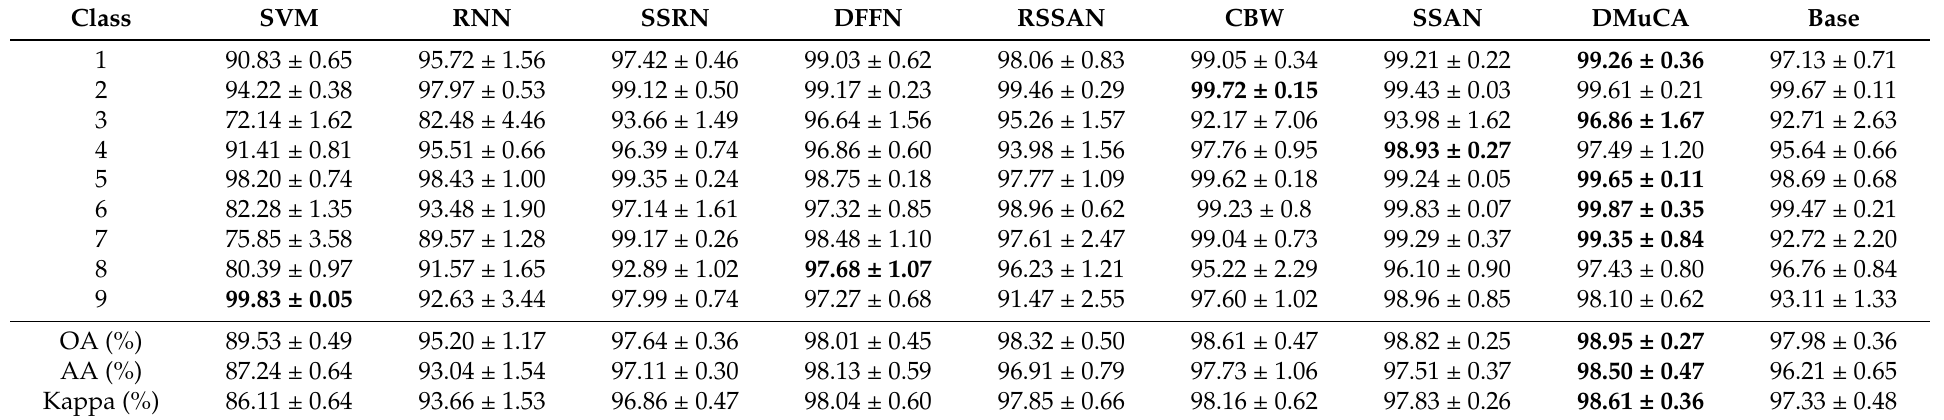
Table 11. Testing results over UP dataset with 3% samples per class for model training. The best results are highlighted in bold